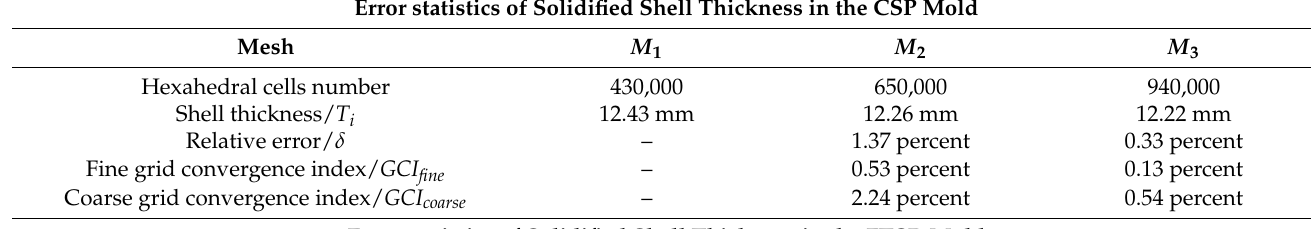
Table 2. Simulation error statistics of solidified shell thickness.